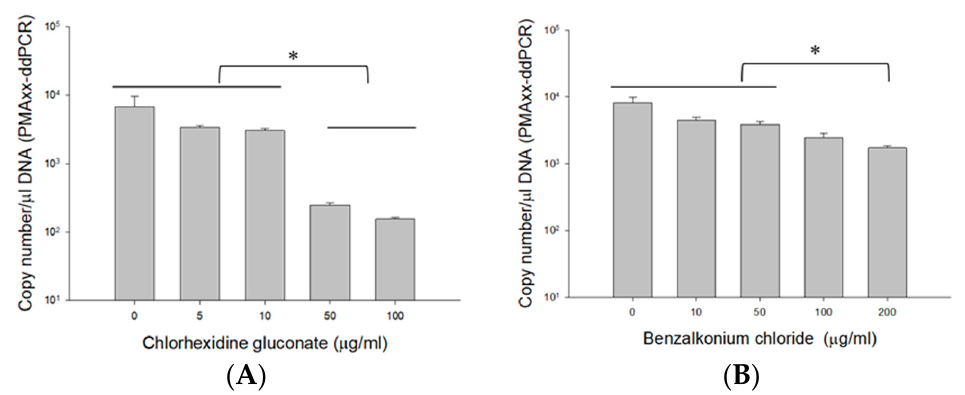
Figure 4. DNA copy number obtained by ddPCR in live B. cenocepacia J2315 (1.5 × 10 8 CFU/mL) cells efficiency of suspensions spiked with 5, 10, 50, 100 µ g/mL CHX ( A ), and 10, 50, 100, 200 µ g/mL BZK ( B ). Error bars in diagrams represent the mean value ± standard deviations obtained in triplicates. The * symbol over each diagram indicates a statistically significant difference, p < 0.05.